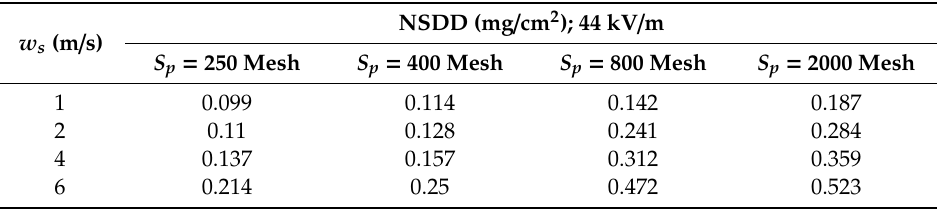
Table 3. NSDD under electrical stress of 44 kV / m.